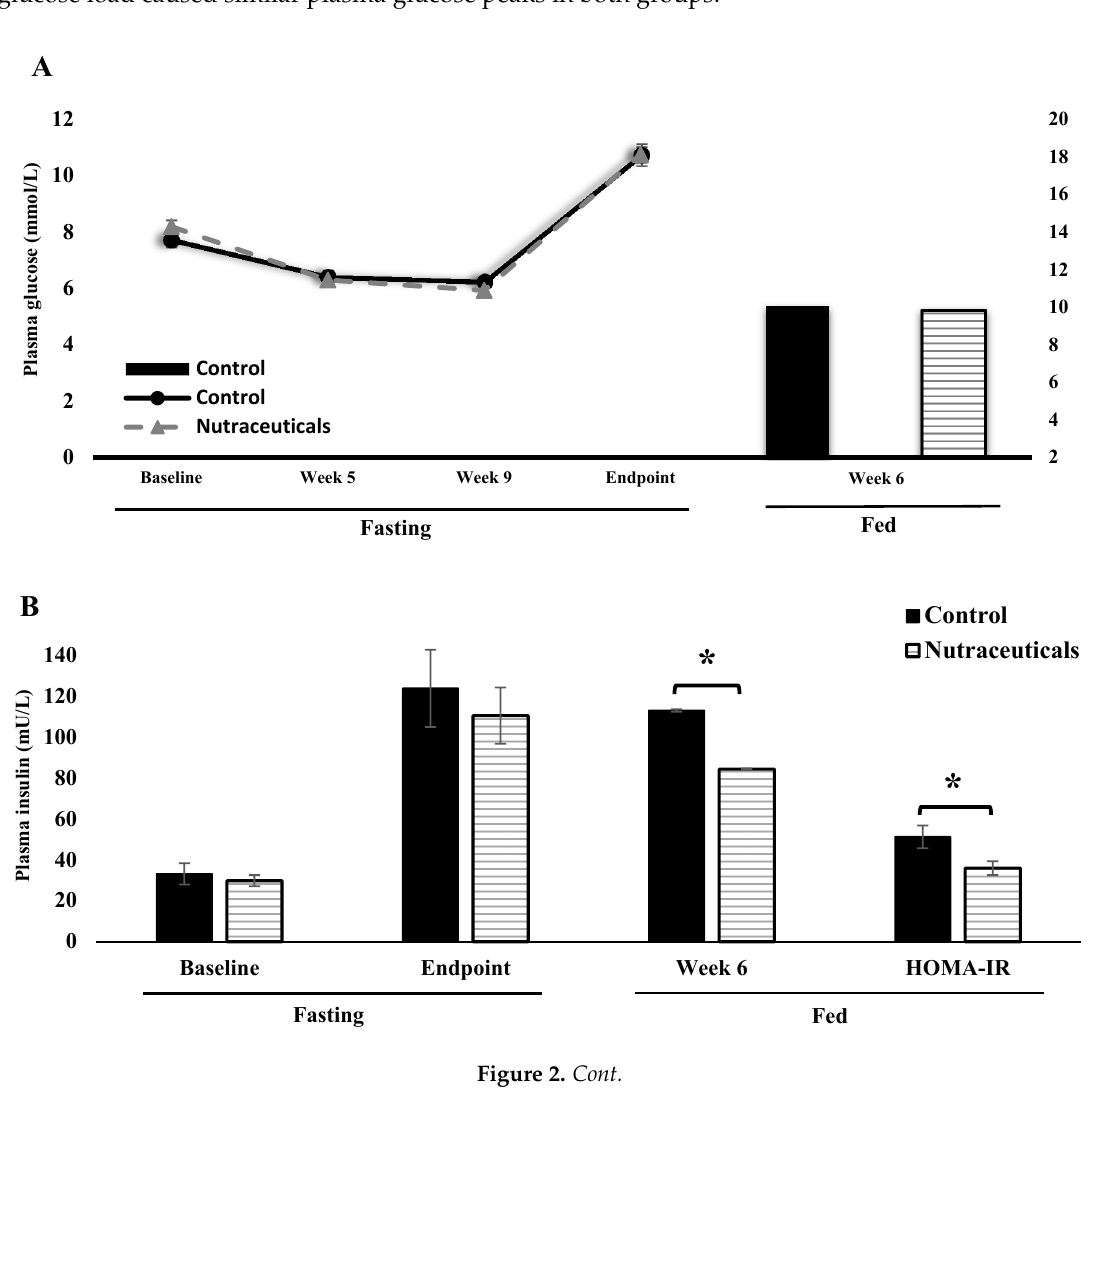
Figure 1. ( A ) Body weight of high-fat/high-fructose-fed rats in both study groups; ( B ) food intake was measured in one day every second week from week 2 to 10, and presented as g/day. No significant difference was found between groups (error bars: standard error of the mean). Nutraceuticals combination consisted of caffeic acid, trigonelline, and cafestol.